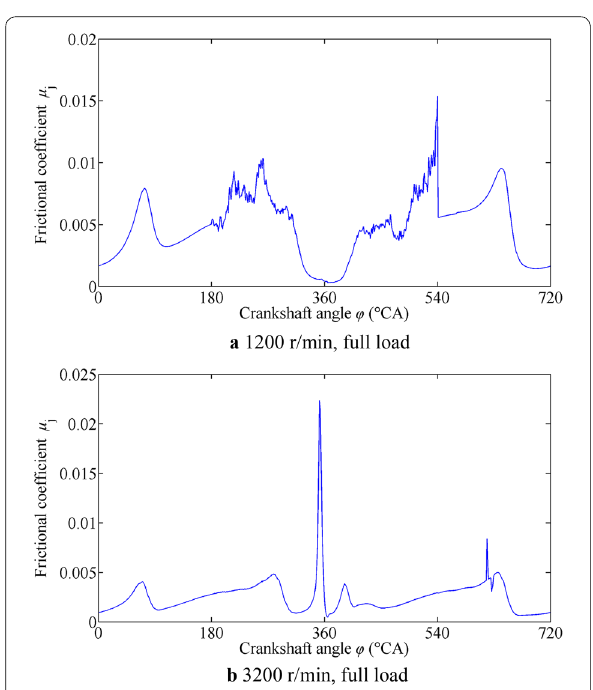
Figure 13 Frictional coefficient of connecting-rod bearing